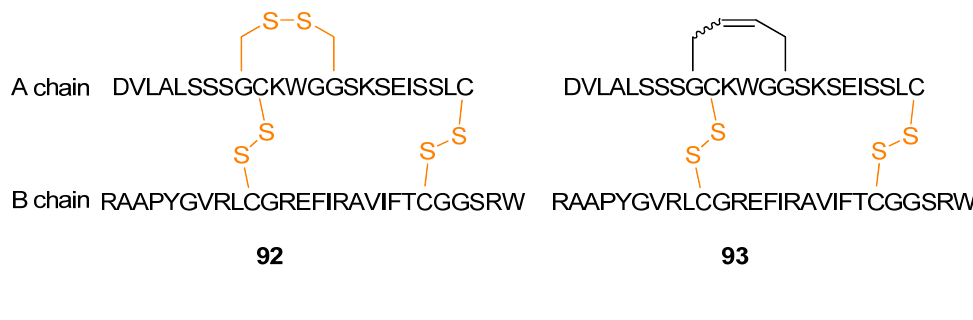
Figure 24. The dicarba analogue 93 of human relaxin-3 92 , also known as insulin-like peptide 7, retains the solution phase structure and biological activity of the parent polypeptide, with potentially improved in vivo stability.